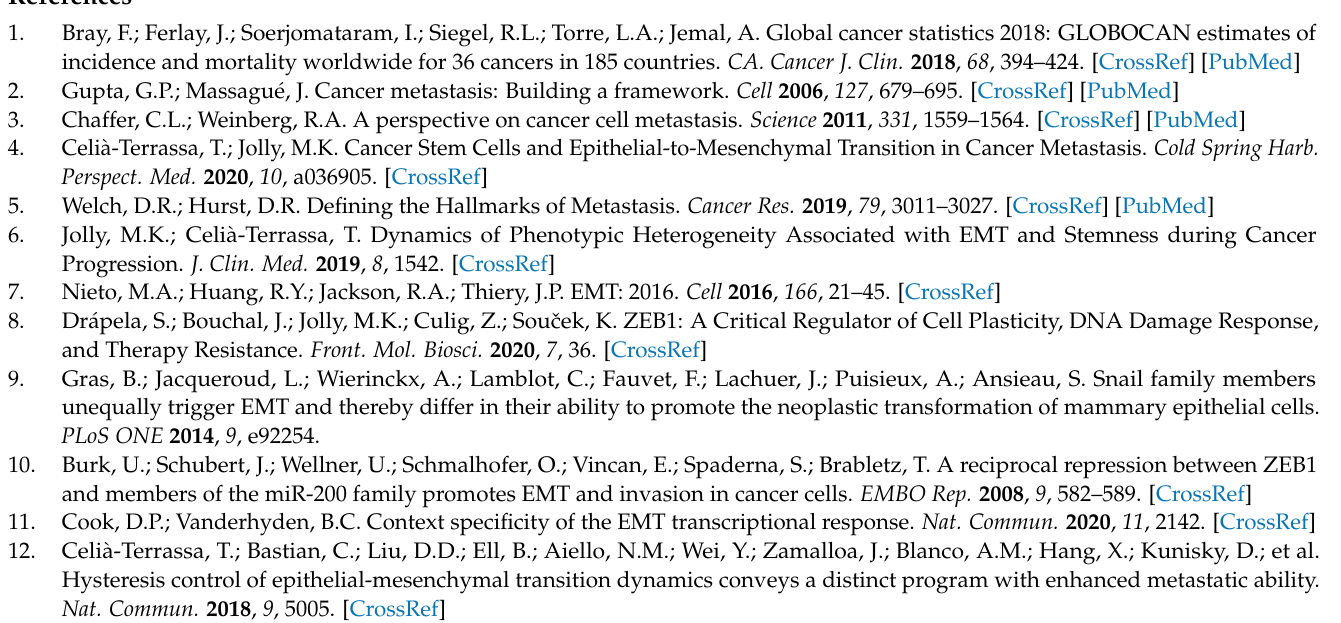
activation, Figure S3: RACIPE analysis of KLF4-EMT circuit, Figure S4: EMT score and methylation of TCGA cancers, File S1: